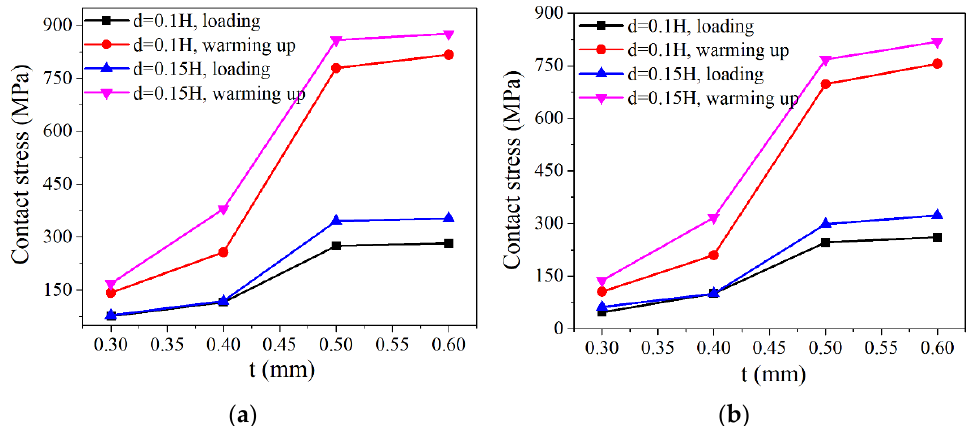
Figure 11. Contact stress of NiTi alloy corrugated gasket with different plate thickness: ( a ) Crest No. 2; ( b ) Trough No. 5.